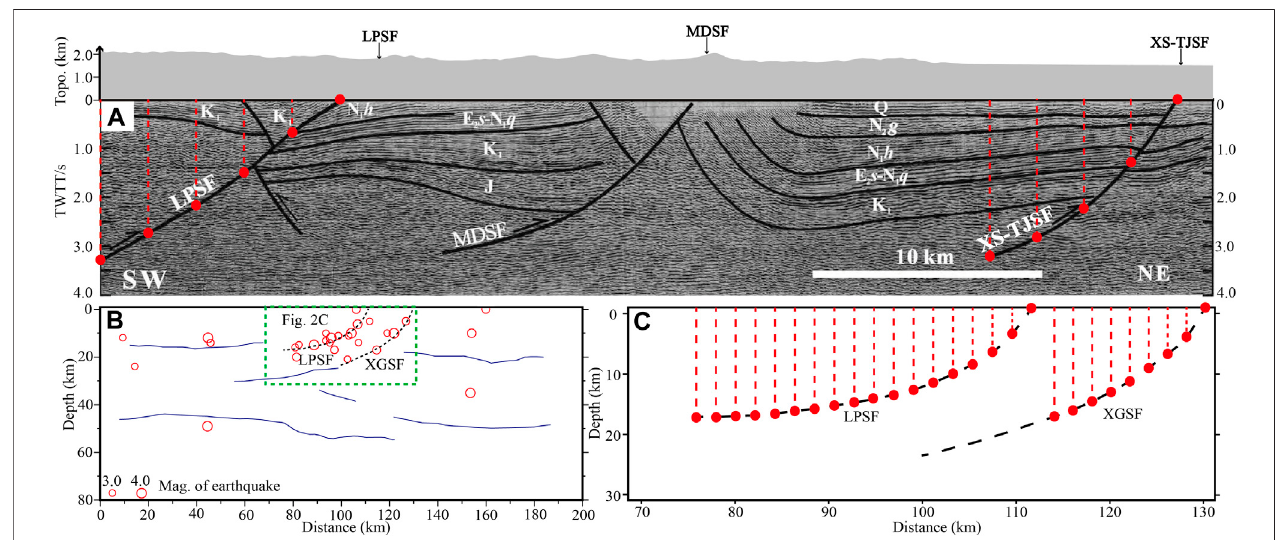
FIGURE 2 | (A) Extraction of fault control points in seismic re fl ection pro fi le [modi fi ed from Wang (2011); Wang et al. (2014)]; (B) Receiver function pro fi le [modi fi ed from Tian et al. (2021)]; (C) Extraction of fault control points in receiver function pro fi le. The locations of pro fi les are shown in Figure 1 . The range of (C) is shown in (B) . Red dashed lines represent auxiliary lines, red solid circles represent control point locations, and red hollow circles represent earthquakes of magnitude 3.0 and 4.0. MDSF, Madongshan